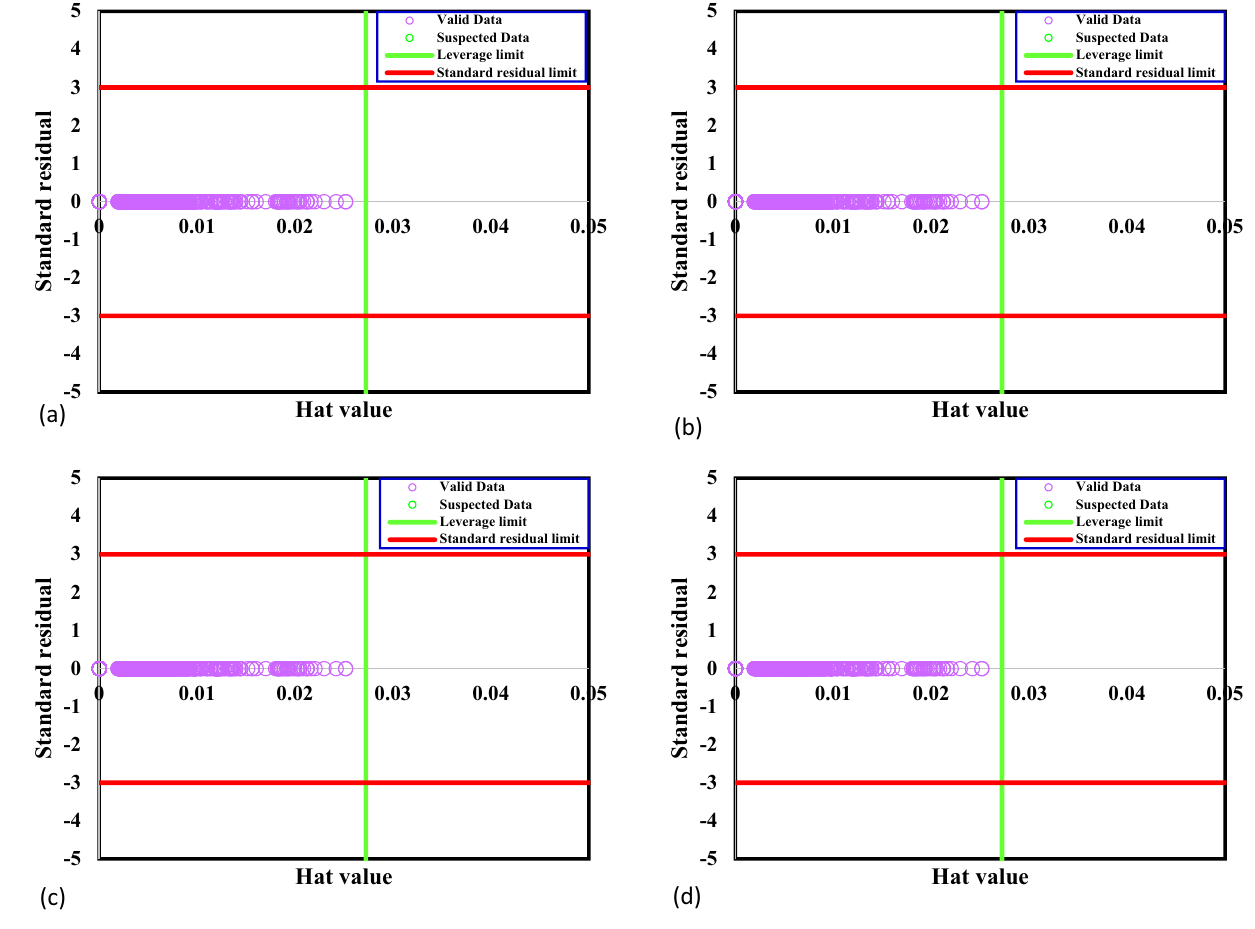
Figure 1. Detection of outliers for GPR model containing kernel function of ( a ) exponential, ( b ) matern, ( c ) squared exponential and ( d ) rational quadratic.